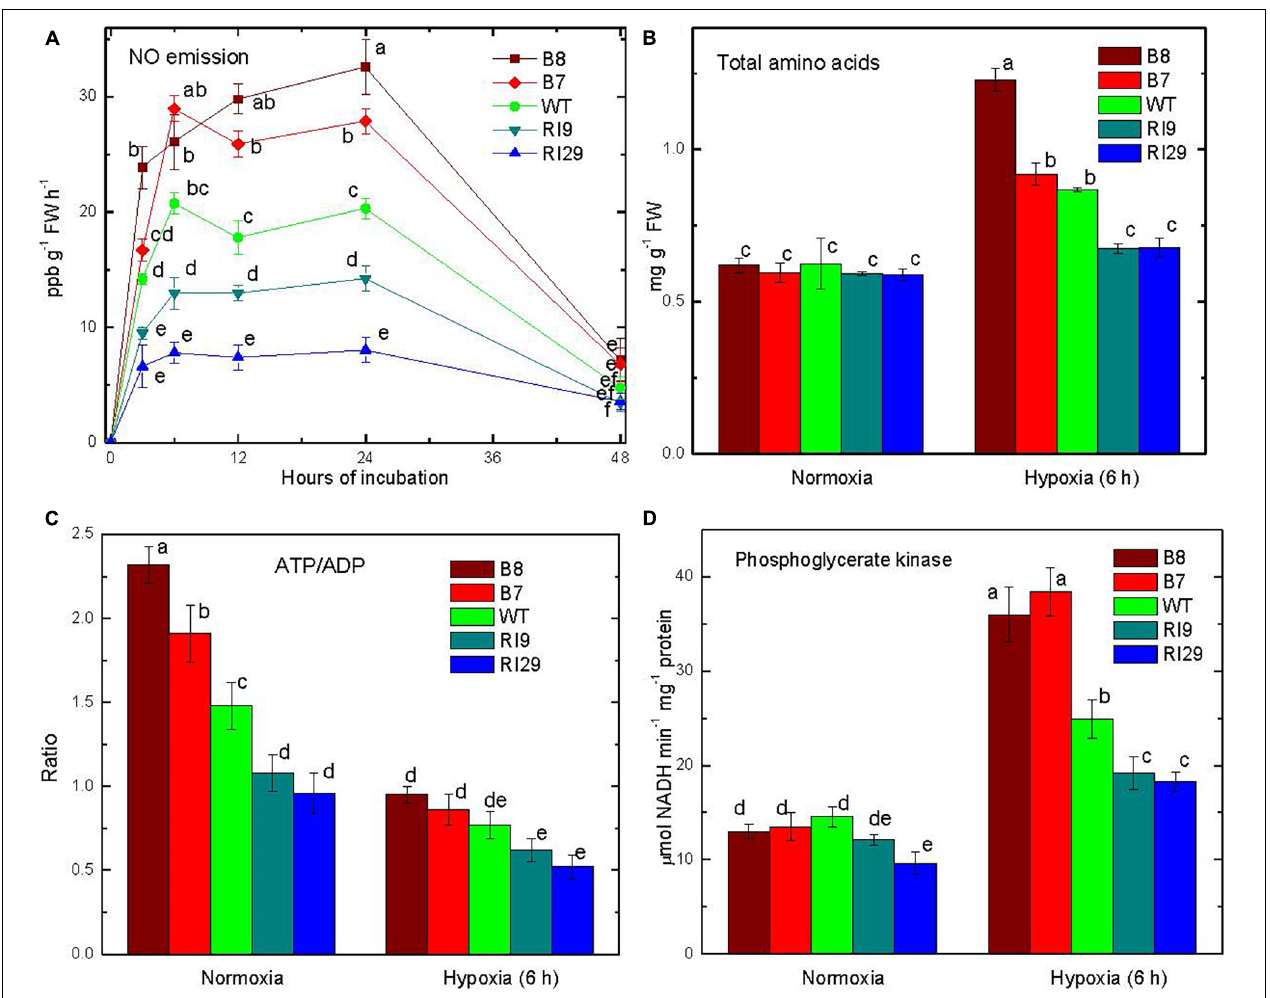
FIGURE 1 | Leaf nitric oxide emission (A) , total amino acid content (B) , ATP/ADP ratio (C) , and phosphoglycerate kinase activity (D) in tobacco plants with differing amounts of alternative oxidase, and exposed to hypoxia (at time 0 in A ). The plant lines used included wild type (WT), two alternative oxidase overexpressors (B7, B8), and two alternative oxidase knockdowns (RI9, RI29). Vertical bars indicate SD from three to four independent experiments ( n = 3–4); different letters indicate significant differences between five tobacco lines and the time